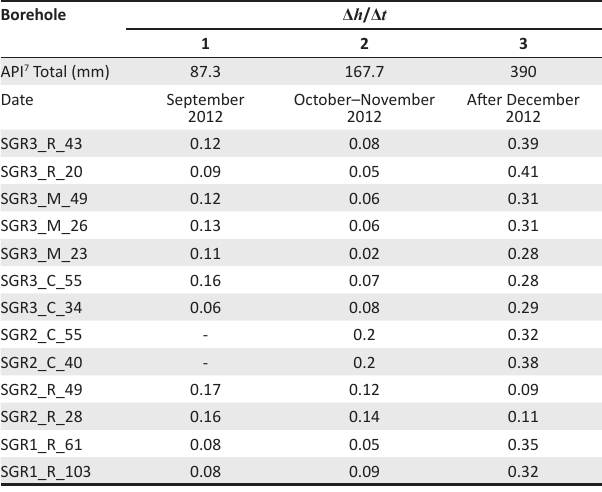
TABLE 2: Groundwater head (m) changes expressed against the seven-day Antecedent Precipitation Index periods during 2012–2013.